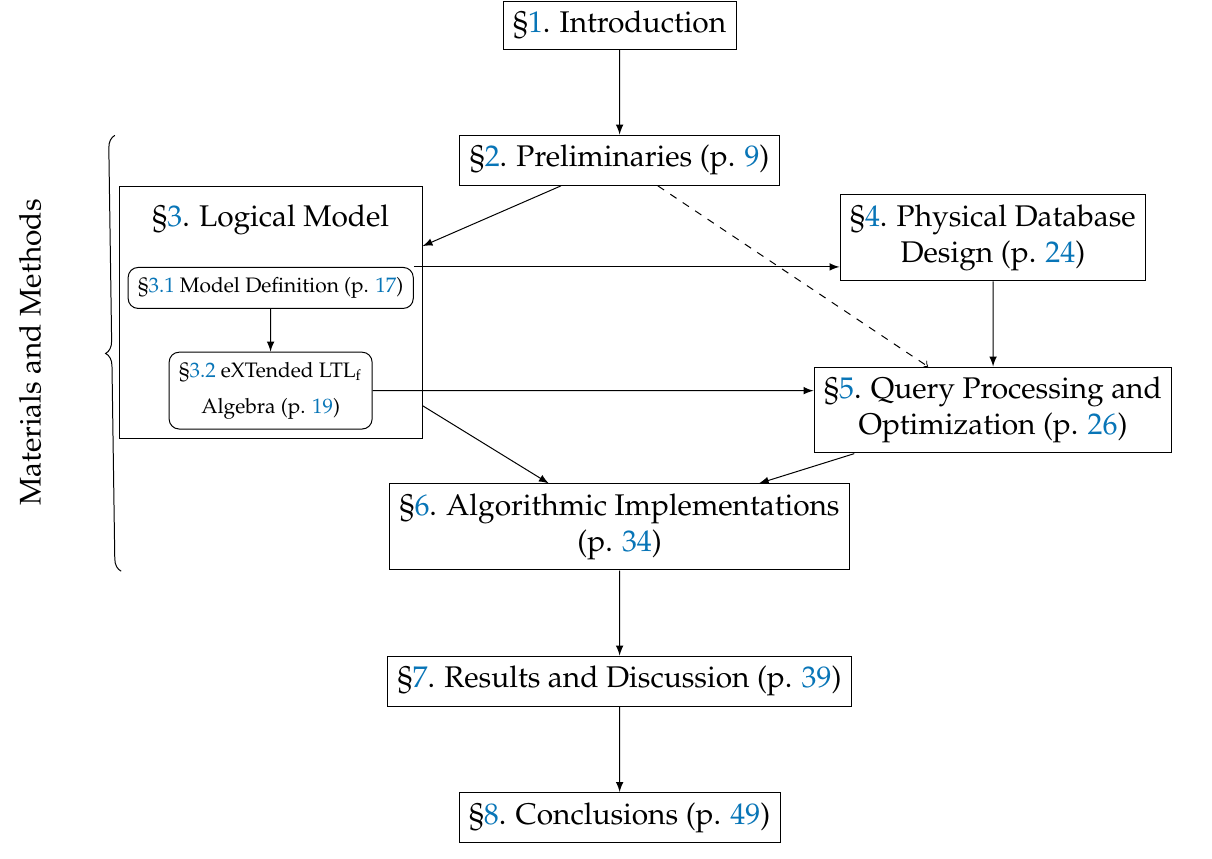
Figure 1. Table of